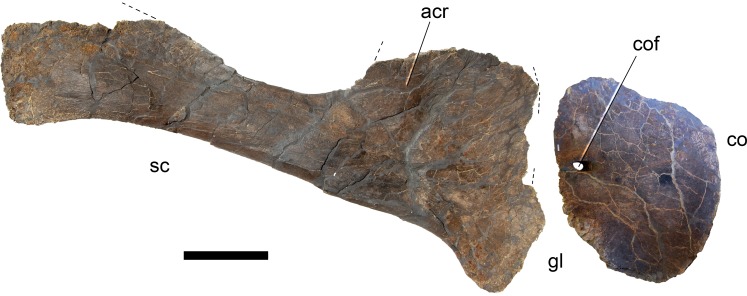
Right scapula and coracoid of Galeamopus pabsti SMA 0011 in lateral view.Lacking parts indicated with dashed lines. Abb.: acr, acromion ridge; co, coracoid; cof, coracoid foramen; gl, glenoid; sc, scapula. Scale bar = 20 cm.